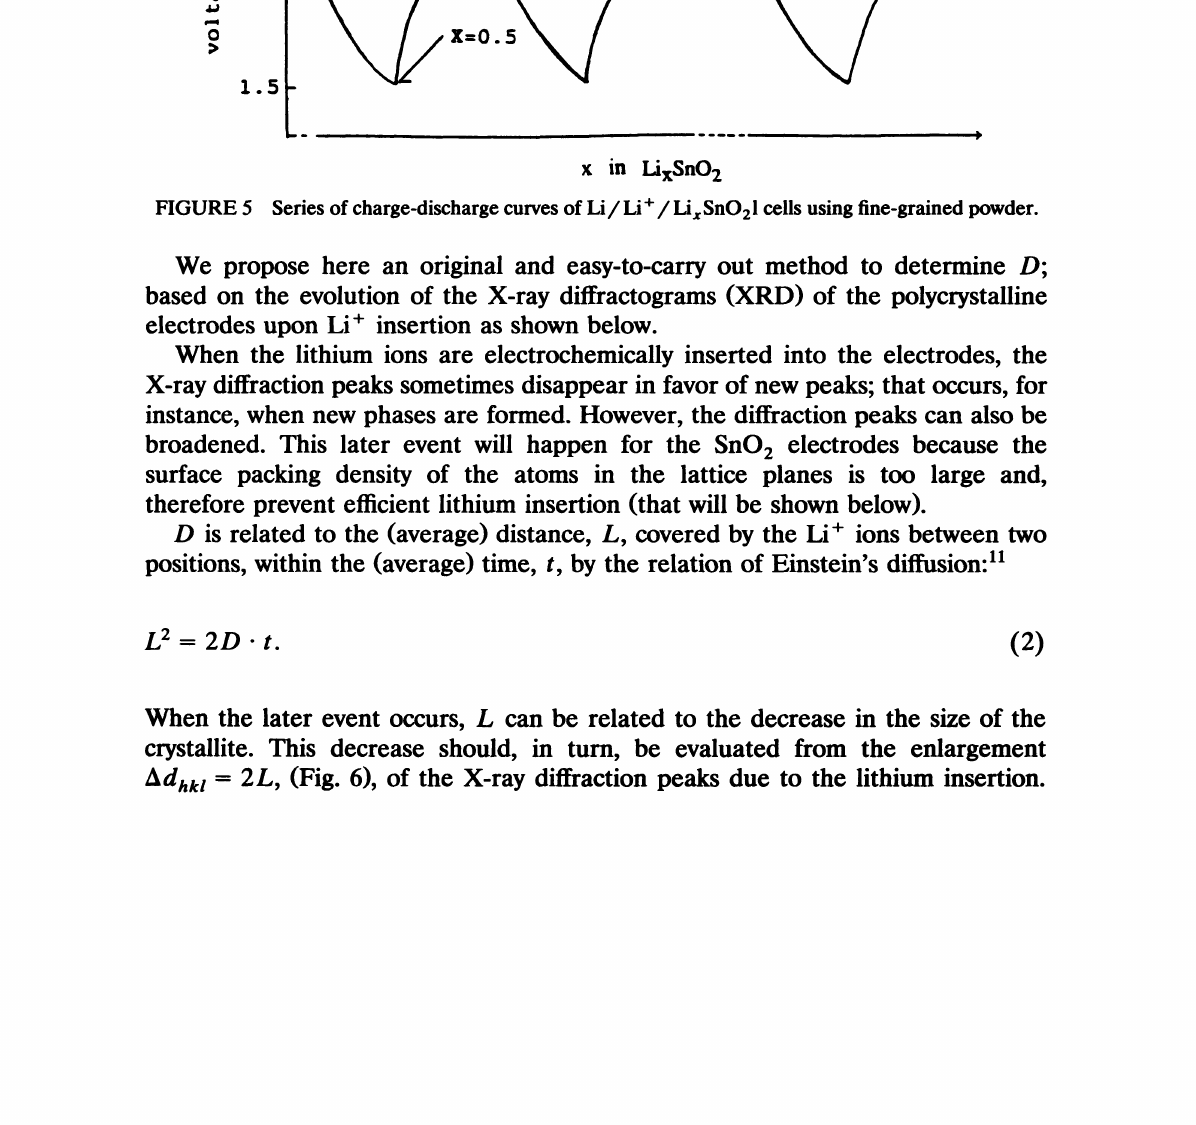
FIGURE 4 Third discharge curves of Li/Li+/LixSnO Li. The current density was 50/A/cm 2 for an electrode weight of 35 rag.